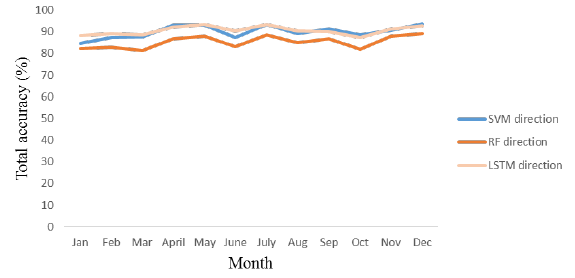
Figure 3: Total accuracy for different months for Stuttgart (in direction case).